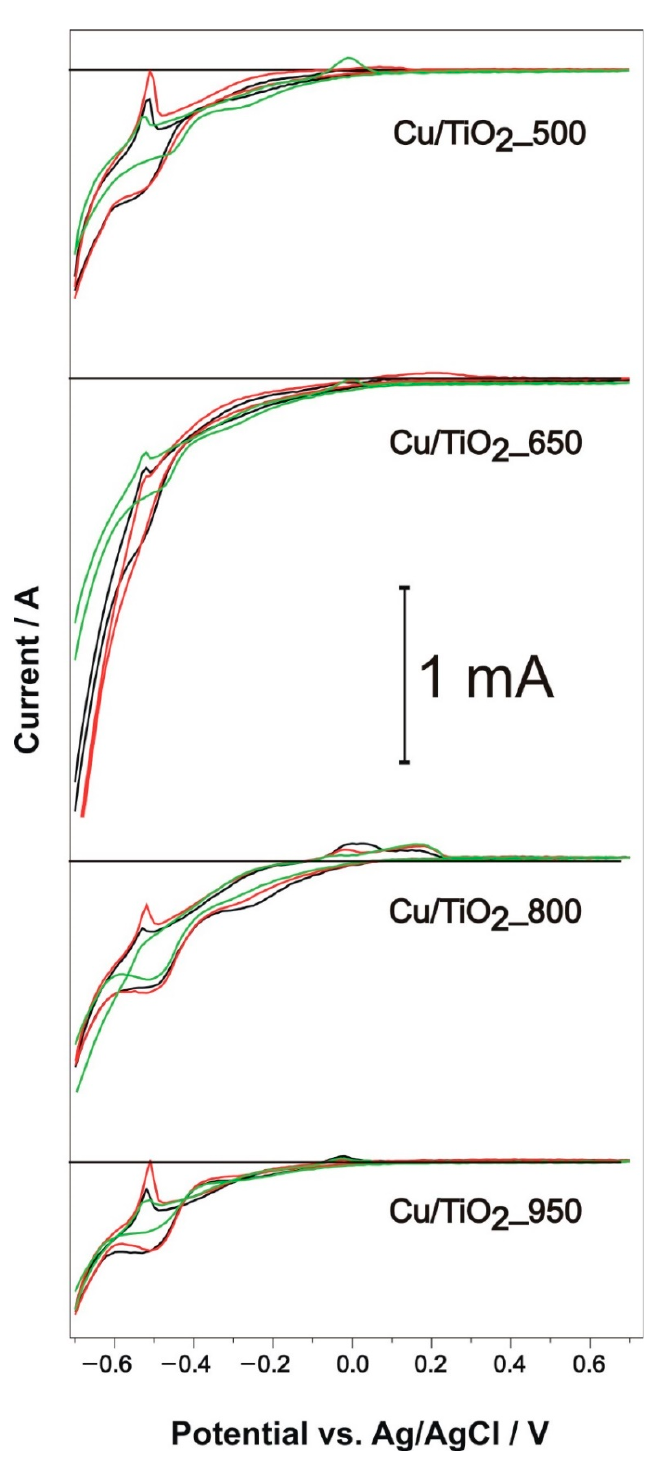
Figure 14. Results of PEC water splitting for samples Cu/TiO 2 _500, Cu/TiO 2 _650, Cu/TiO 2 _800 and Cu/TiO 2 _950. Black lines (2nd photoelectrochemical cycle) and red ones (7th photoelectrochemical cycle) were obtained for the experiments carried out under irradiation. Green lines represent the dark electrochemical